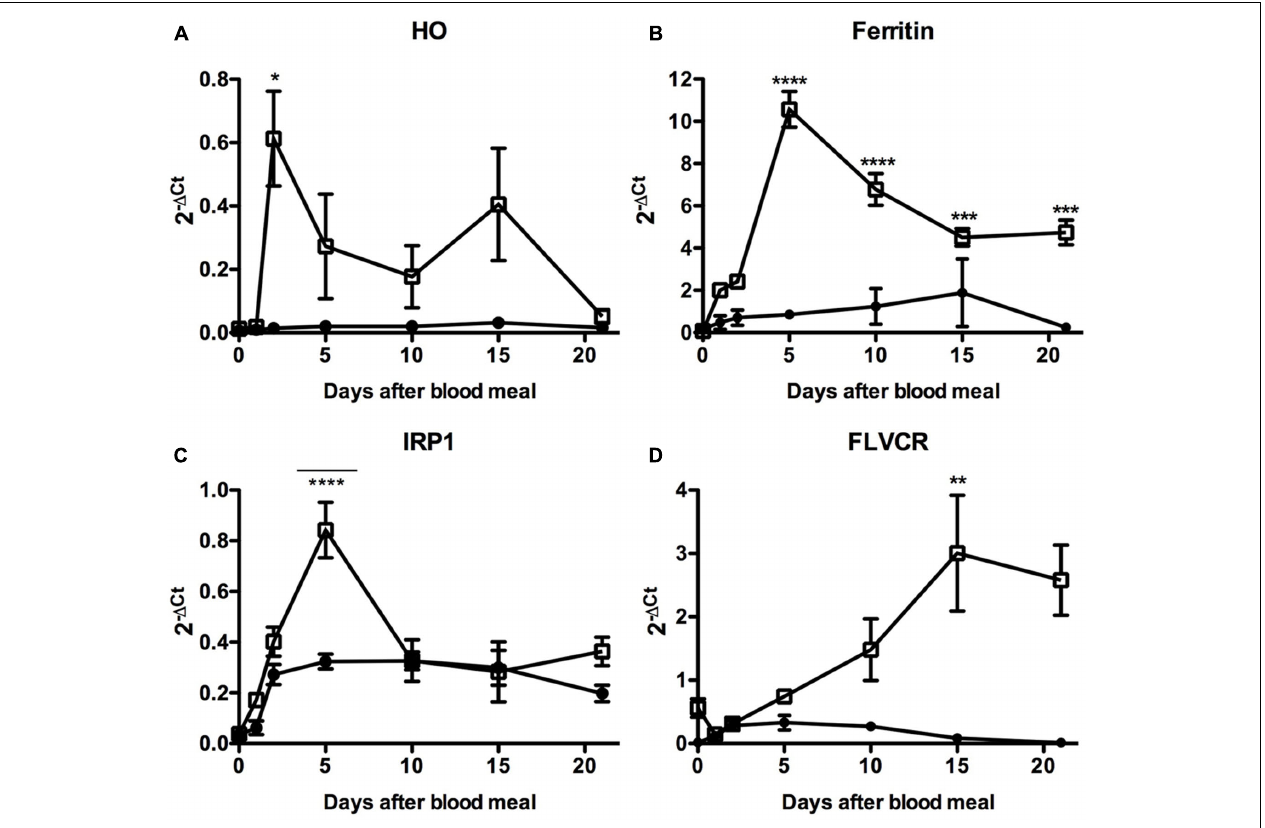
FIGURE 10 | Expression analysis of key genes involved in iron and heme metabolism in the insect midgut compartments. R. prolixus adult females were fed on blood and the anterior and PMs were dissected immediately before (day 0) or at the indicated times after the blood-meal for qPCR analysis. Heme oxigenase (A) , Ferritin (B) , Iron Responsive Protein 1 (IRP1) (C) , and Feline Leukemia Virus subgroup C Receptor (FLVCR) (D) . The elongation factor 1 gene (RPRC007684) was used as an endogenous control ( n = 12–15). Data shown in all graphics are mean ± SE. One-way ANOVA followed by Tukey’s multiple comparison test was used to evaluate differences in gene expression during the days after blood ingestion. ∗ p < 0.05, ∗∗ p < 0.01, ∗∗∗ p < 0.05, ∗∗∗∗ p < 0.0001. These data are resulted from three independent